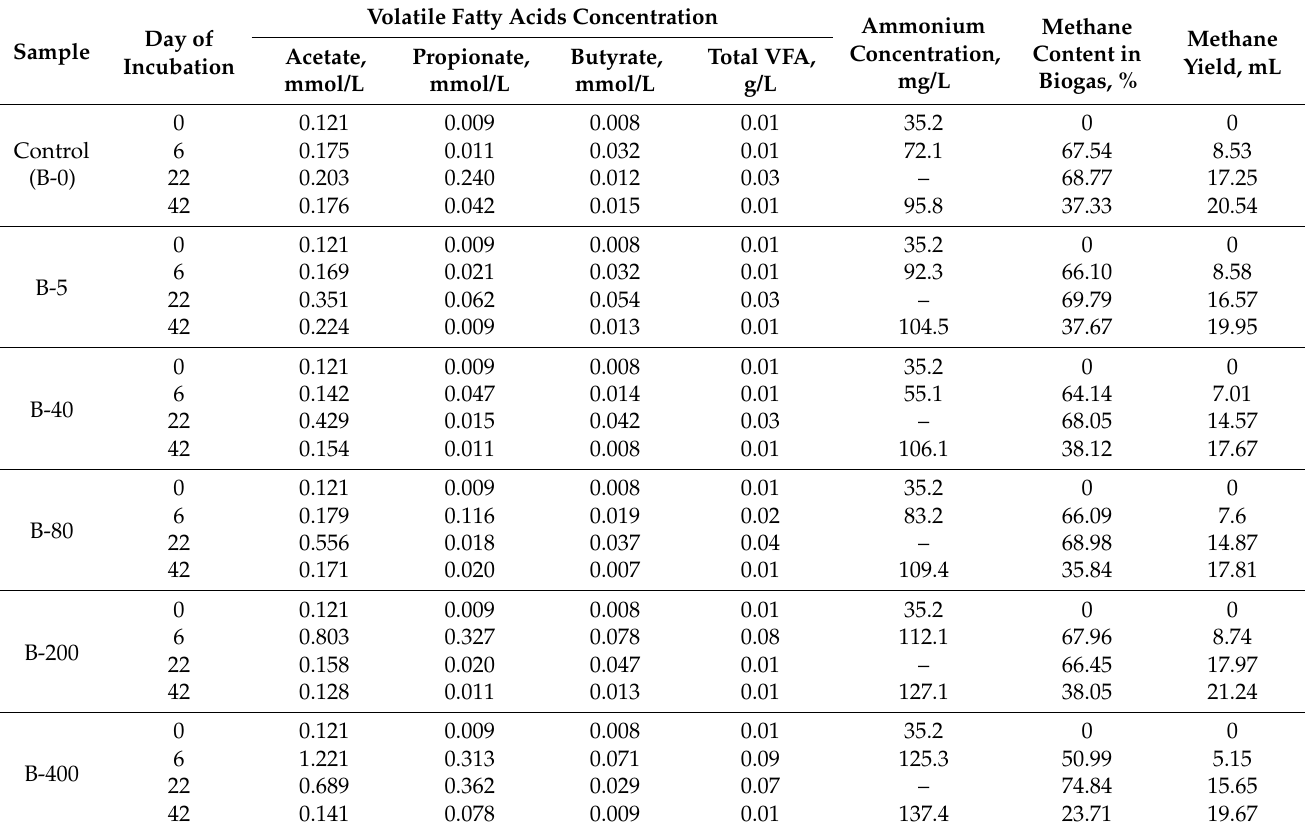
Table 2. Characteristics of the process in the course of batch incubation of the mixture of digested sludge with different concentrations of the polyacrylamide flocculant as a